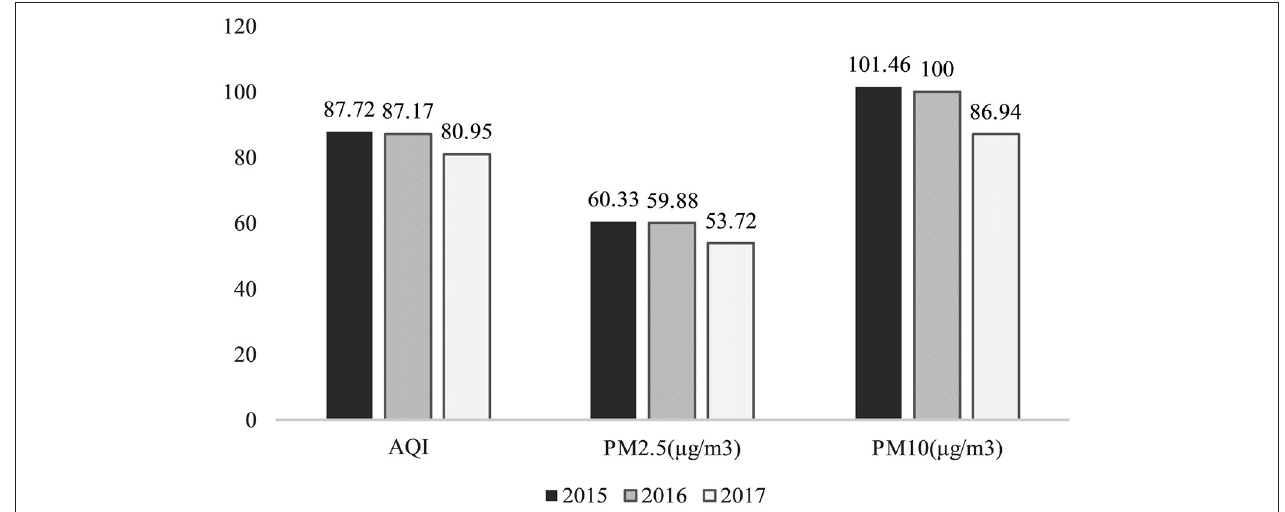
FIGURE 1 | Annual air quality in sample city,